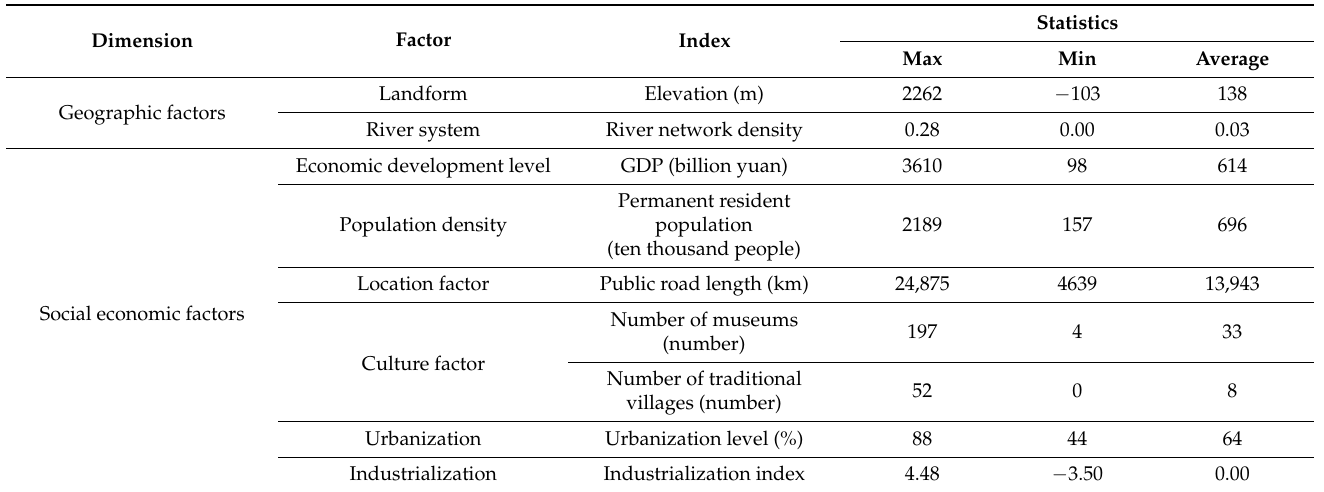
Table 1. Influence factors and data